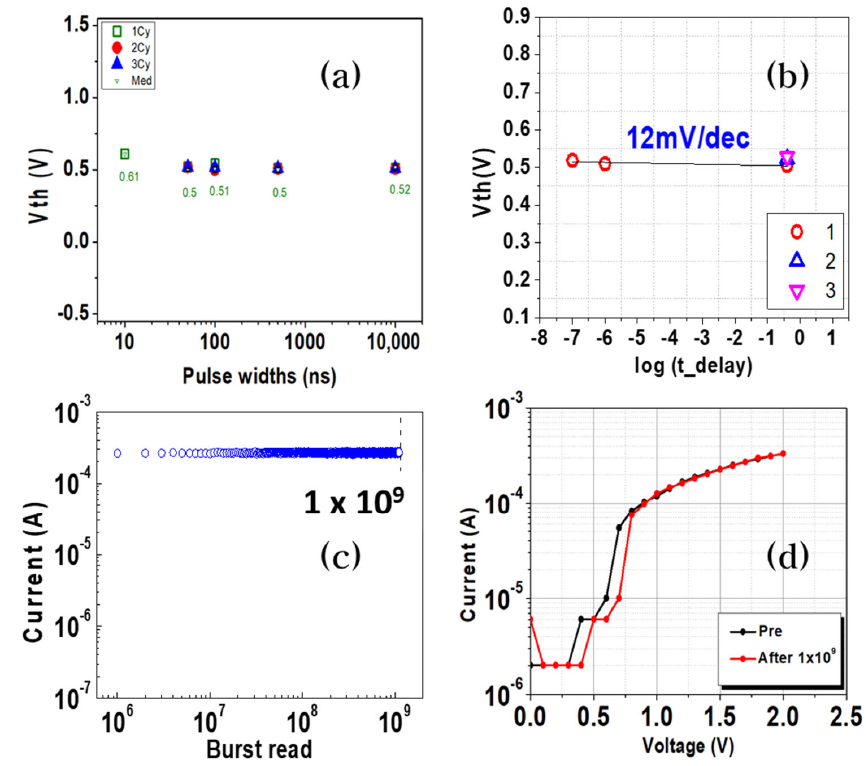
Figure 3. ( a ) Threshold voltage (Vth) endurance with different pulse widths. Even though the